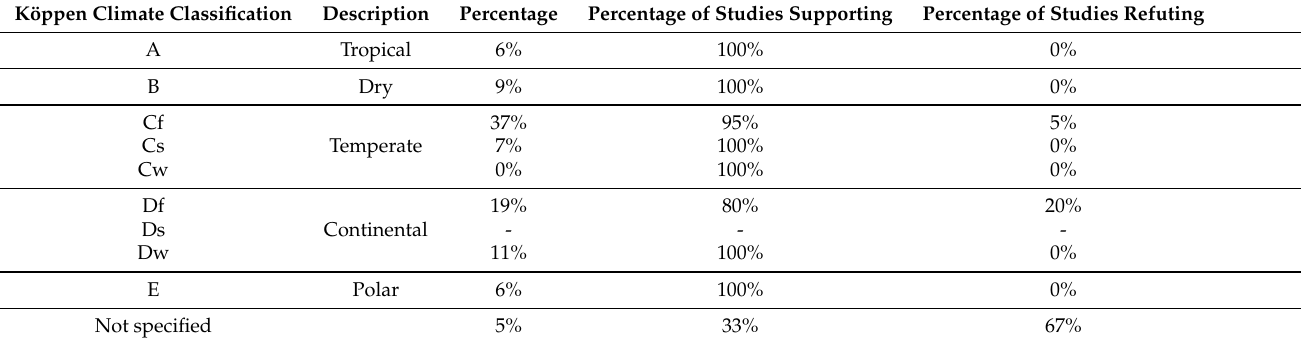
Figure 4. Location of studies on Köppen–Geiger climate classification map (1926–2022) based on the climate map produced by [128] (Red cross: refuting studies; Black dot: corroborating studies). Table 1. Climate distribution of